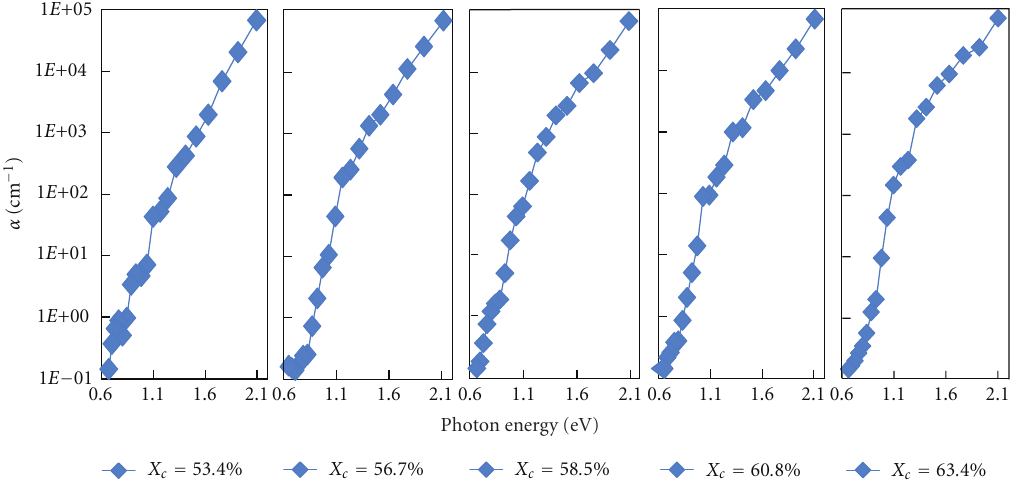
Figure 3: Absorption coe ffi cients of μ c-Si:H thin films for the corresponding cells.